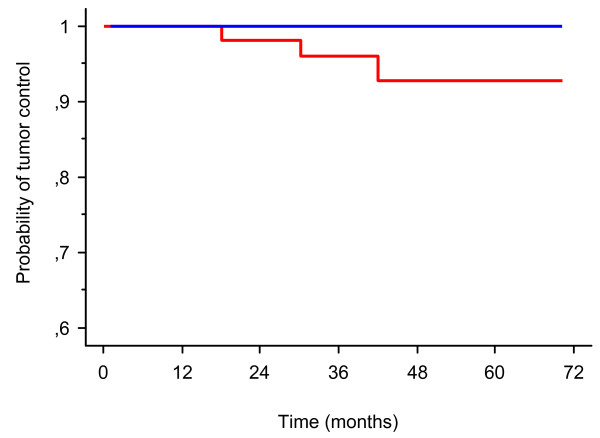
Kaplan-Meier analysis of tumor control (red line) and overall survival (blue line) rates after FSRT of 52 large benign skull base meningiomas.